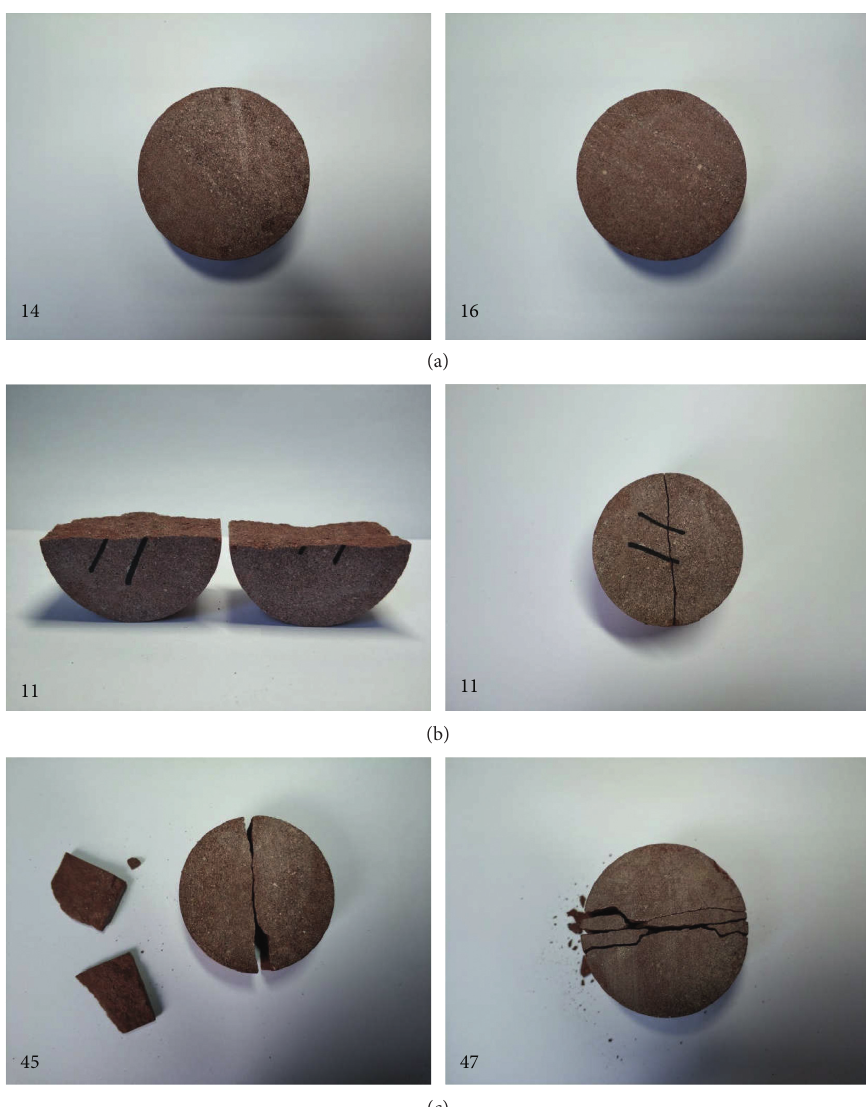
Figure 3: Three failure states of red sandstone specimens after impact: (a) unruptured state; (b) ruptured state; (c) broken